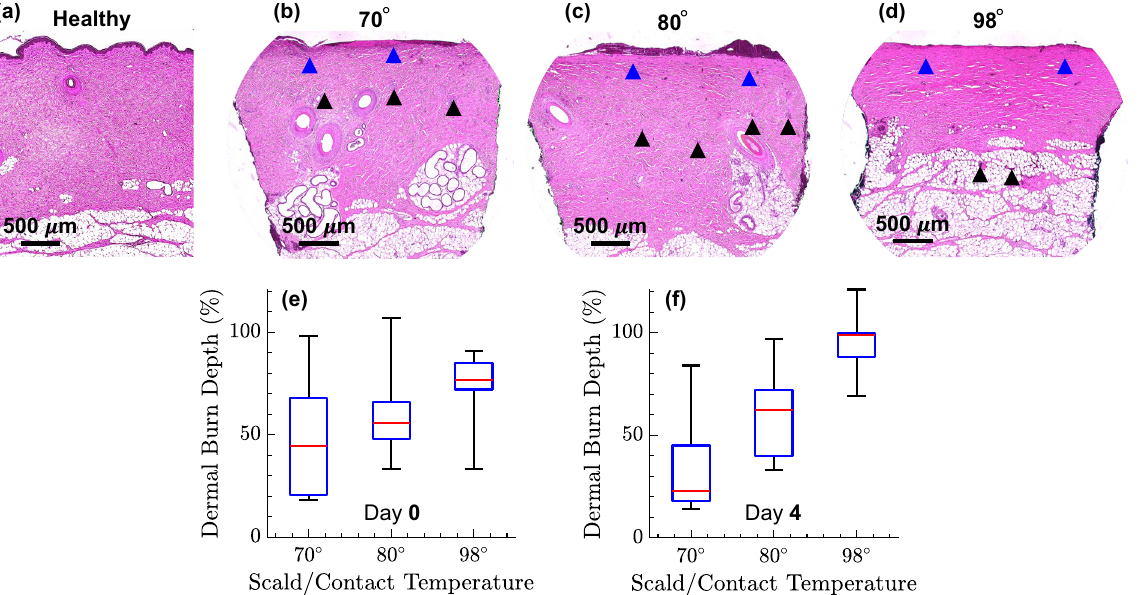
Figure 2. ( a – d ) Microscopic images ( 5 × magnification) of the H&E-stained biopsies from the healthy skin (control experiment) and three representative burns created using 70 and black arrows indicate the areas of collagen denaturation and vascular occlusion, respectively, ( e ) the dermal burn percentage measured on the biopsies on Day 0, and ( f ) Day